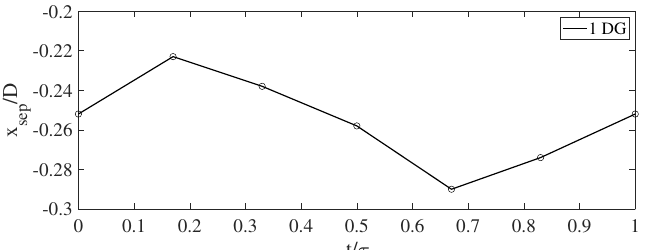
Figure 7. Time behavior of the separation point on the lateral side of the boat-tail for y / D > 0 during the vortex-shedding cycle.